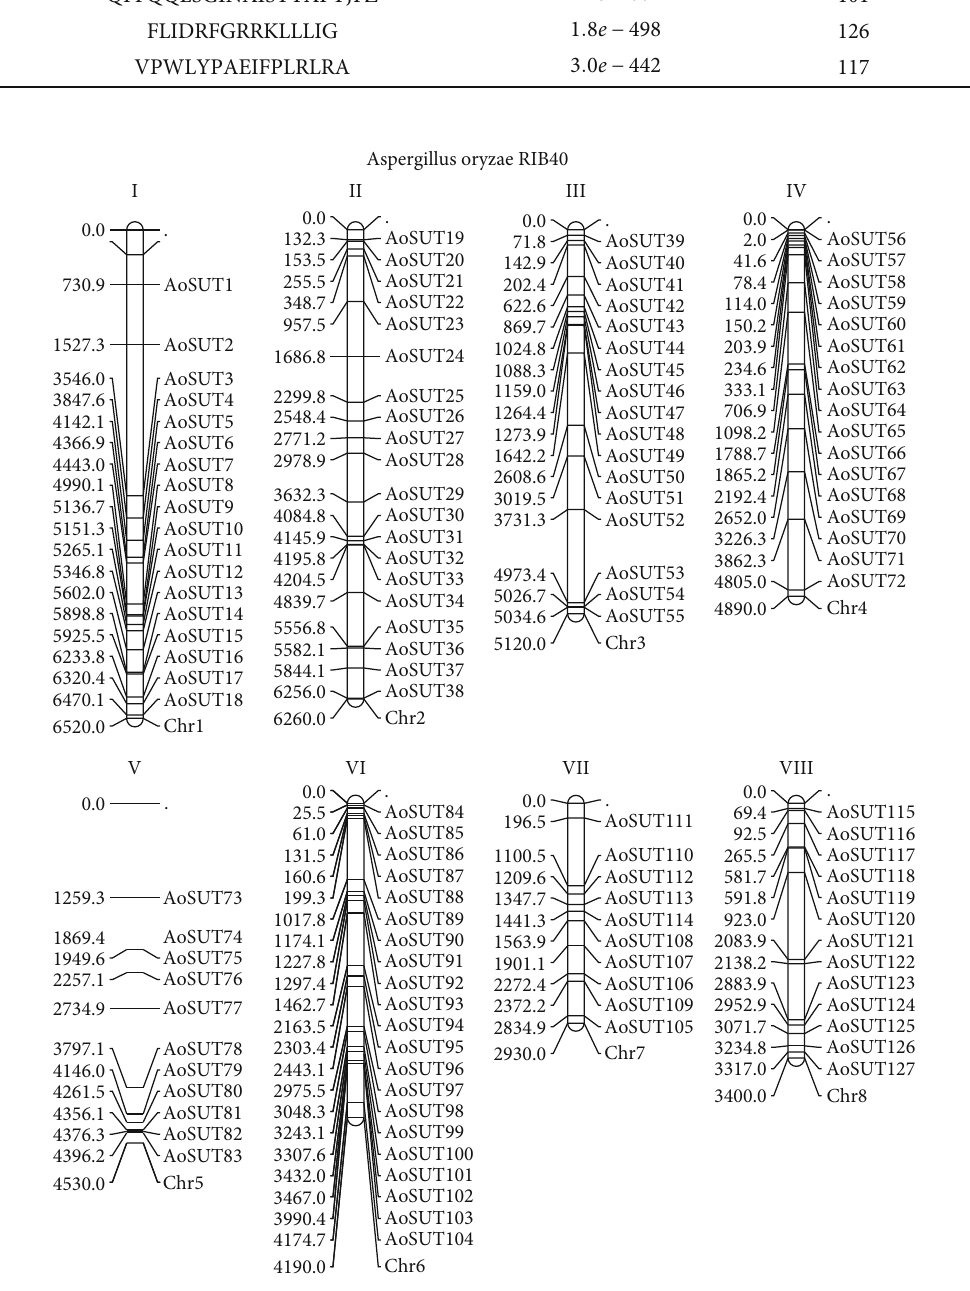
Figure 3: The chromosomal locations of AoSUT genes in the A. oryzae genome. Chromosomes I-VIII are depicted as bars. The AoSUT genes are indicated by black